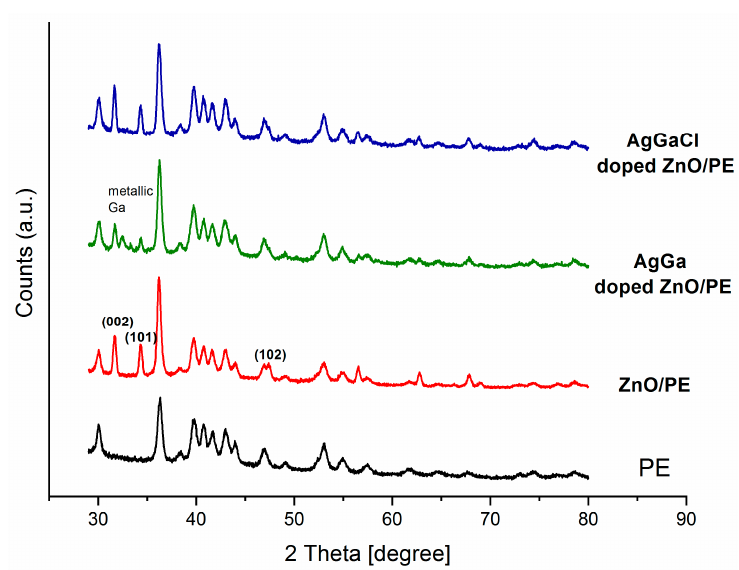
Figure 3. XRD di ff raction patterns of PE, undoped ZnO NRs on PE, AgGa-doped ZnO NRs on PE and AgGaCl-doped ZnO NRs on PE substrate.